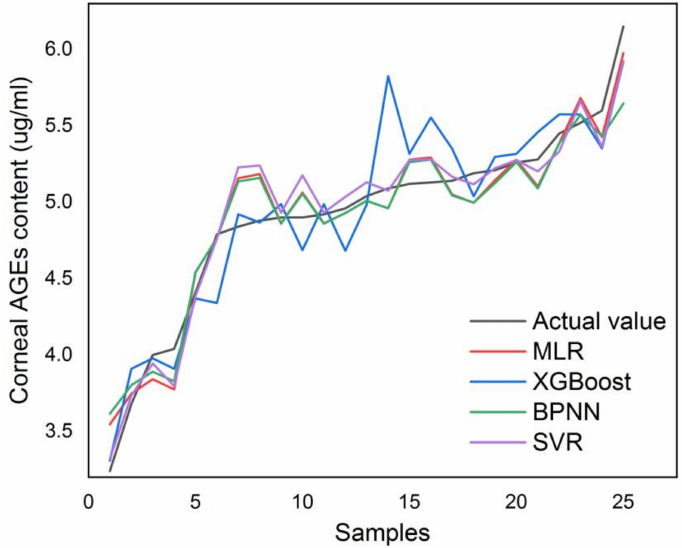
Figure 8. Comparison of the